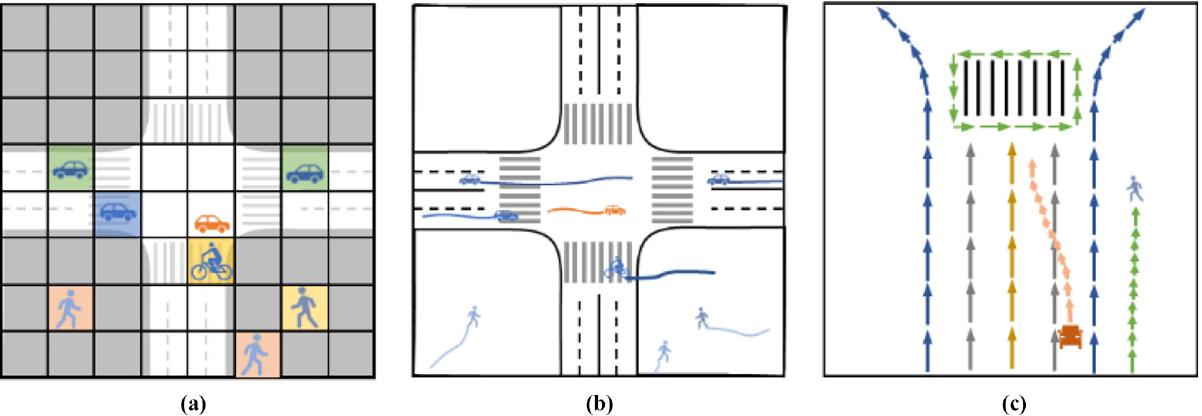
Figure 1 Several methods of feature